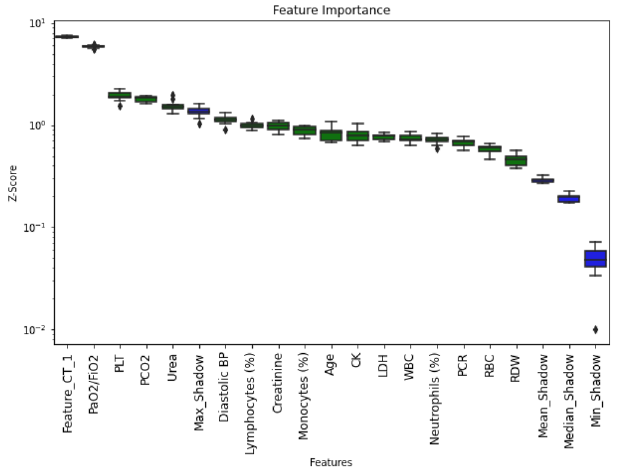
Figure 5. A representative BorutaSHAP importance plot. Green are features to keep in the model for this fold. Blue are maximum, mean, median and minimum shadow features.